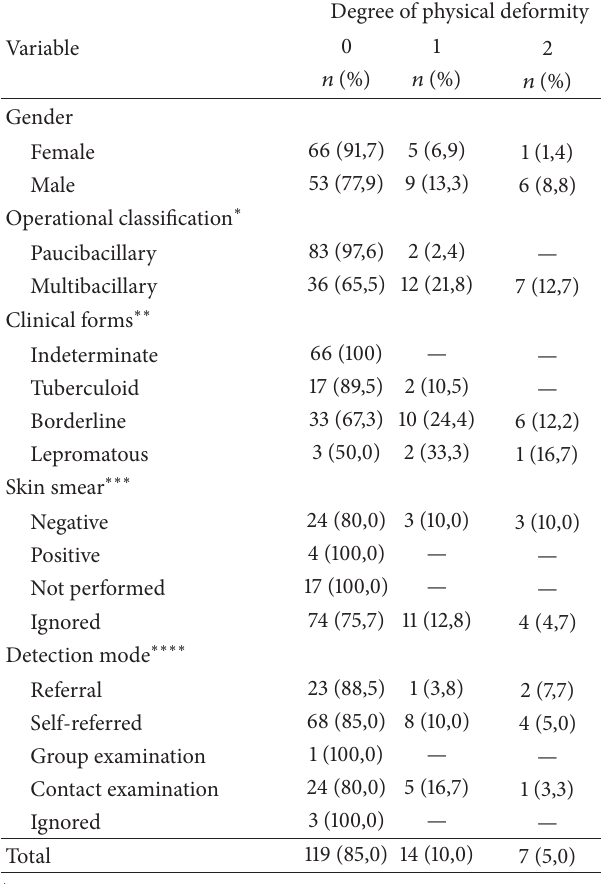
Table 2: Clinical and epidemiological features of notified leprosy cases in children under 15 years old according to their degree of deformity in Almenara, Arac¸ua´ı, and Diamantina between 1998 and 2010.